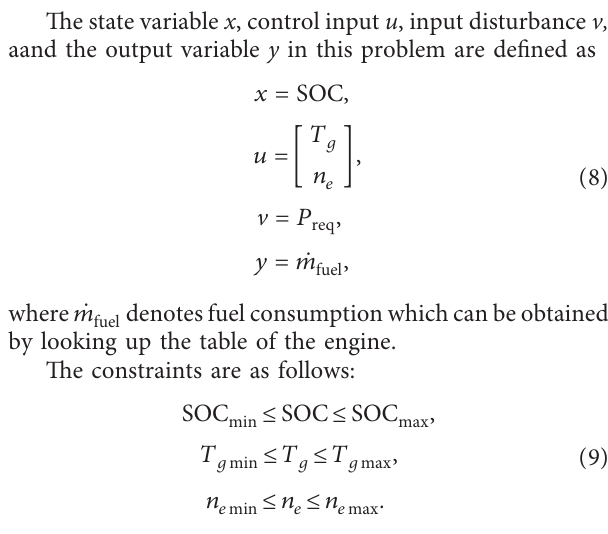
Figure 6: Velocity prediction